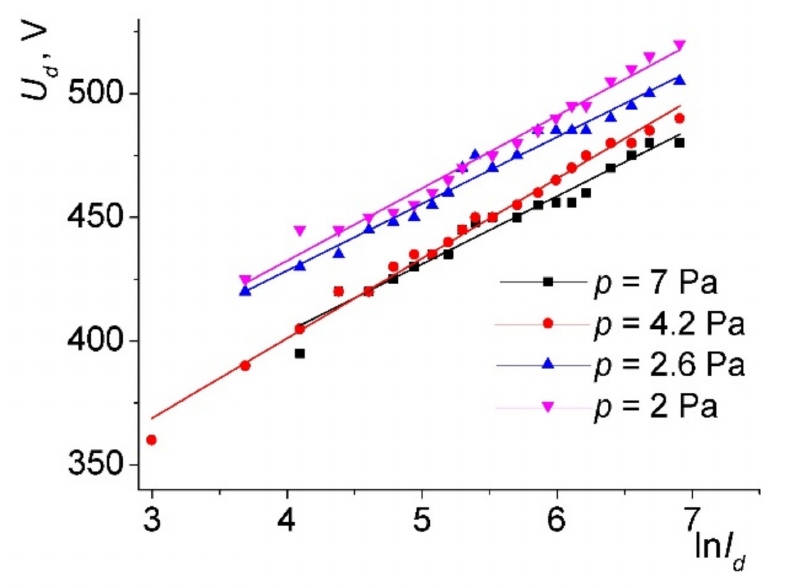
Figure 3. Current–voltage characteristic of the discharge in oxygen at semi-logarithmic coordinates for different pressures.